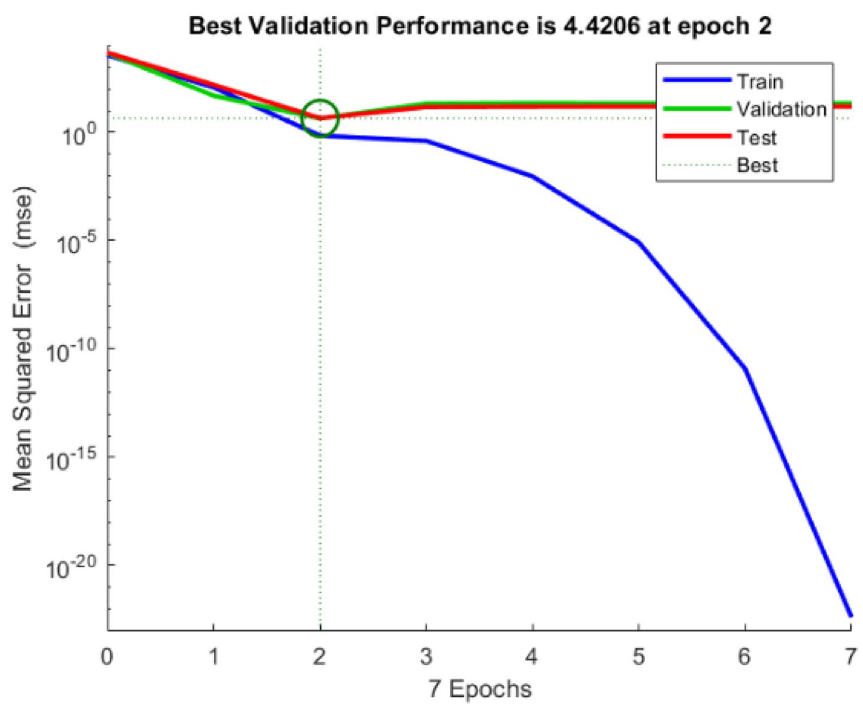
Figure 7. MSE vs epoch for training, validation, and testing sets.